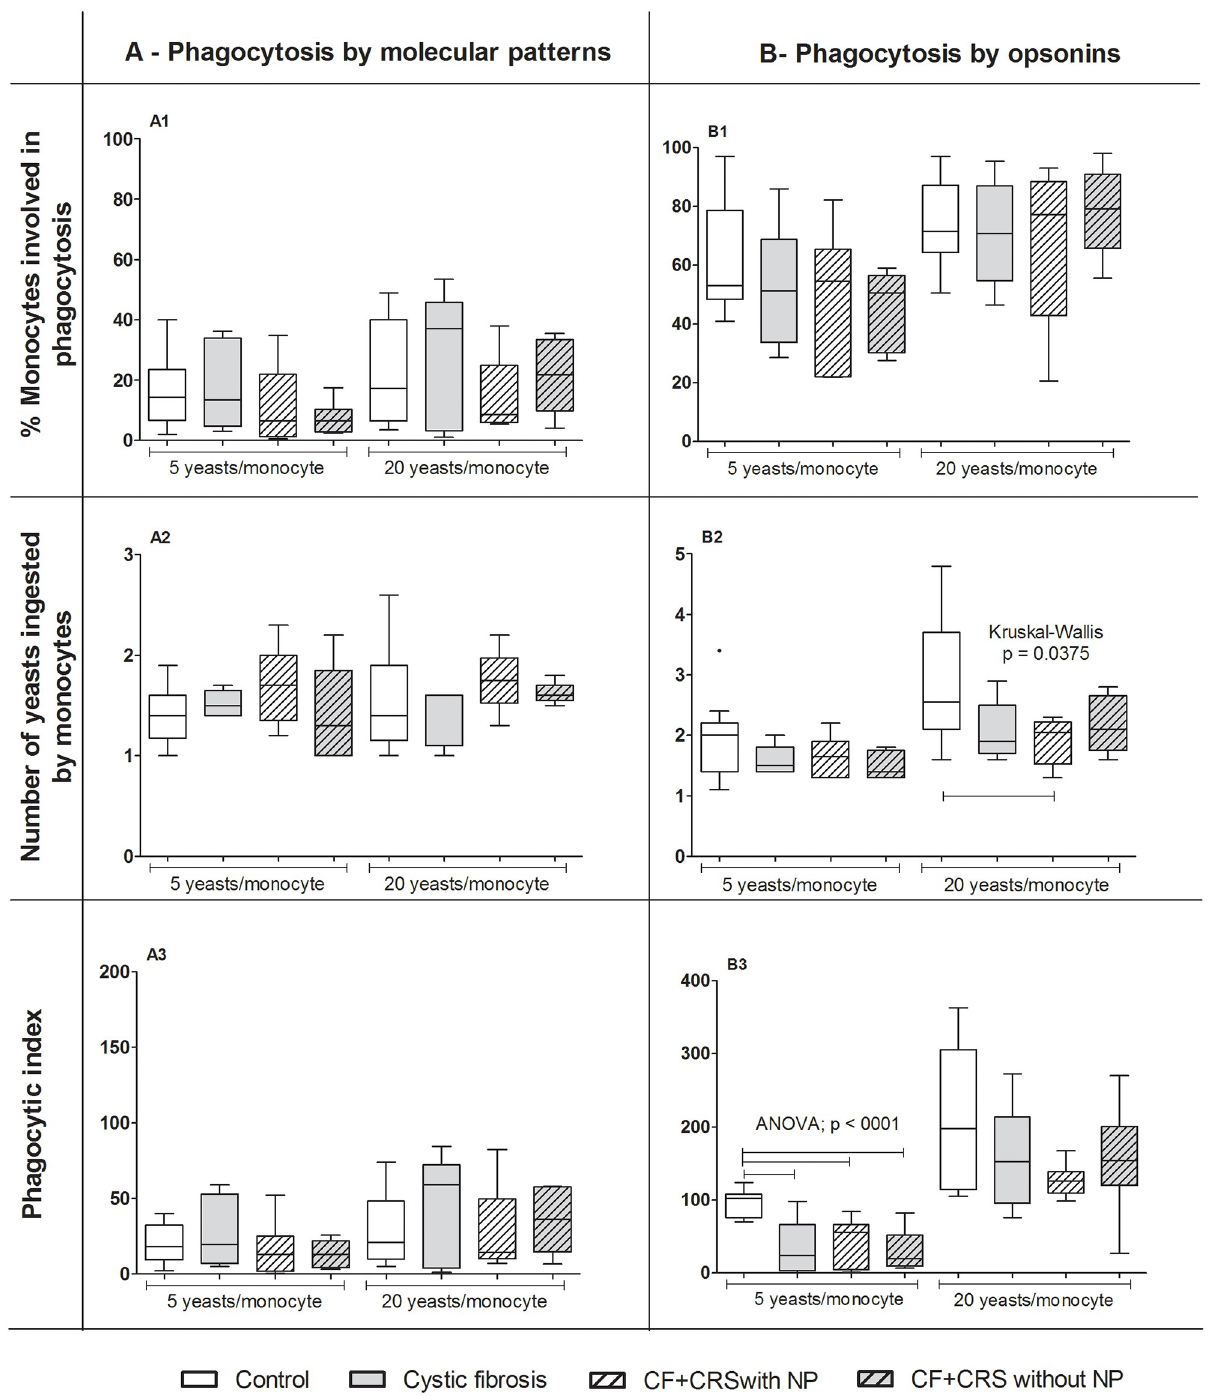
Fig 2. Phagocytosis by monocytes. Phagocytosis of Saccharomyces cerevisiae cells by pathogen-associated molecular pattern (A) and opsonin receptors (B) by blood peripheral monocytes in children. Groups: Cystic fibrosis (CF) n = 6; cystic fibrosis plus chronic rhinosinusitis and presenting nasal polyps (CF+CRS with NP) n = 6; cystic fibrosis plus chronic rhinosinusitis but without nasal polyps (CF+CRS without NP) n = 5; control group (n = 14). In the top, % of neutrophils involved in phagocytosis, in the middle, number of yeasts ingested by neutrophils and in the bottom, phagocytic index. Significant results are shown by bar between groups. Values are presented as the median, quartiles, maximum, and minimum values.